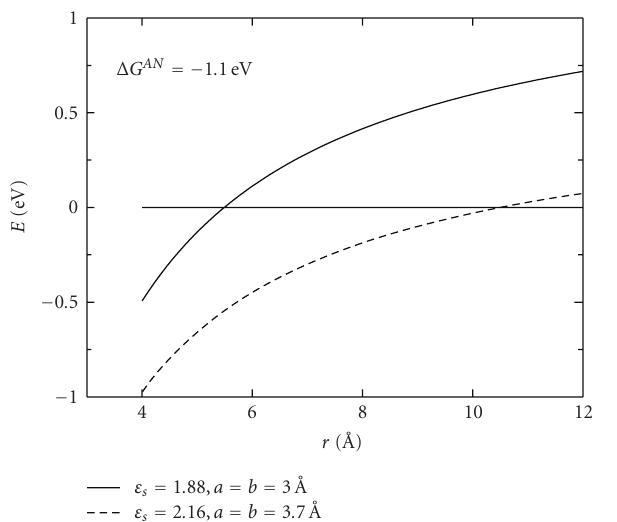
Figure 9: Distribution of ET distance at a quencher concentration of 0.2 M calculated from (20) using R 0 and k 0 determined